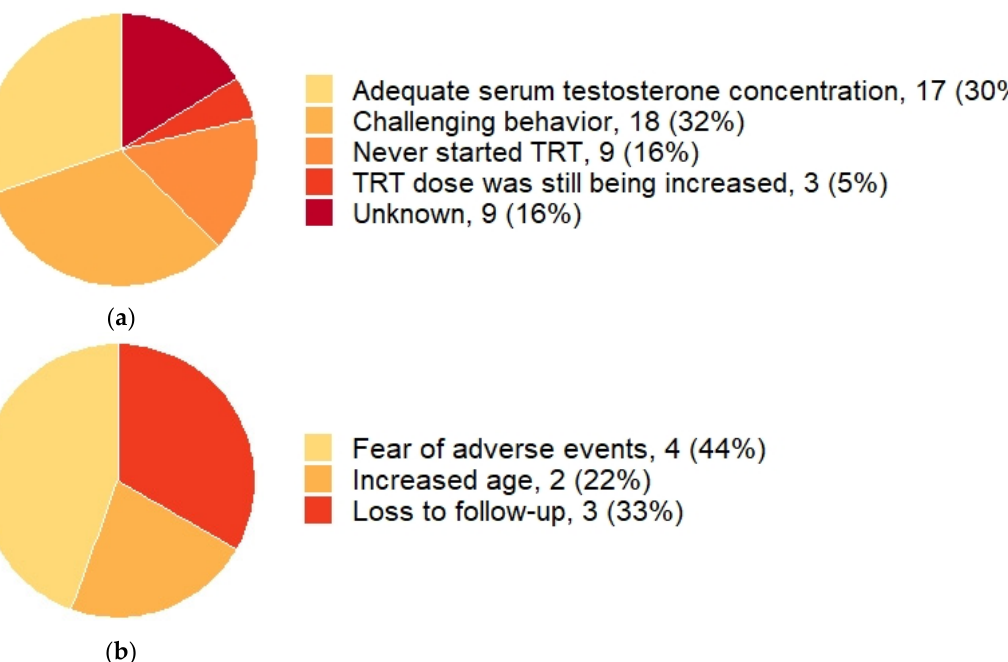
Figure 3. Reasons for not increasing testosterone doses and reasons for not initiating testosterone replacement therapy. Abbreviations: testosterone replacement therapy (TRT). Data is given as n (%). ( a ) The reasons for not further increasing testosterone doses in adult males with PWS and hypogonadism ( n = 56). ( b ) The reasons for never initiating TRT in adult males with PWS and hypogonadism ( n = 9).